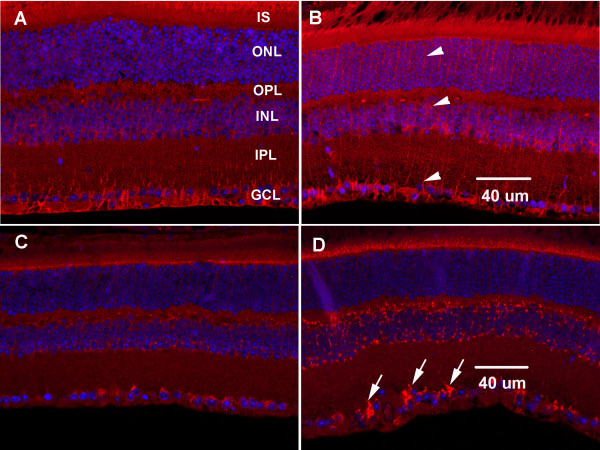
Immunohistochemistry of differentially expressed proteins. A-B: Expression of SOCS3 and C-D: BAX in the control and 6 hrs after optic nerve crush. SOCS3 was expressed throughout the retina and appeared increased in Muller cells (arrowheads) after optic nerve injury. Increased BAX labeling after optic nerve injury was particularly evident in the ganglion cell layer (arrows), consistent with pending programmed cell death of RGCs. Red = target antibody, Blue = DAPI.